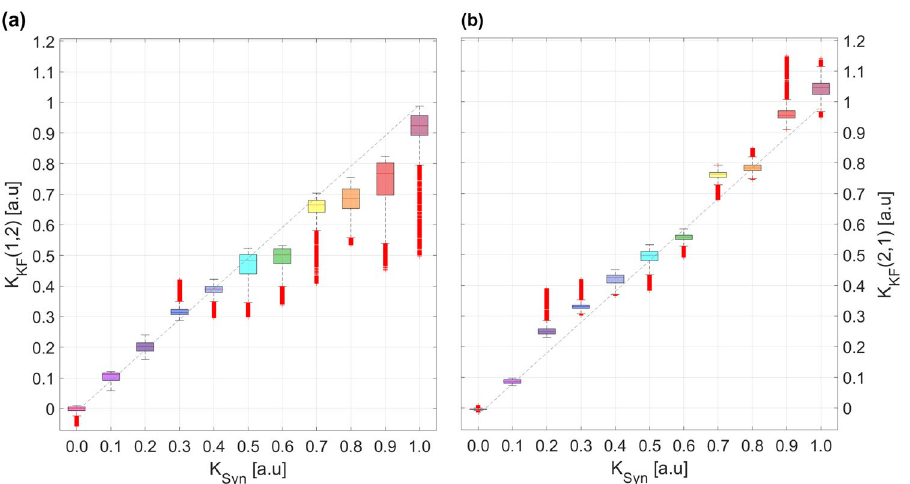
Figure 5. Comparison between the UKF estimated product of the off-diagonal adjacency matrix terms, A 12 and A 21 , times the coupling strength, K ( K 12 ≡ K · A 12 and K 21 ≡ K · A 21 ) versus the real value K . The comparison is made using boxplots. ( a ) Comparison for K 12 . ( b ) Comparison for K 21 . For each boxplot, the red line is the median, the upper and lower whiskers of the bars represent the maximum and minimum limits, and the red points refer to outliers. Each box contains 90,000 data obtained from independent runs of the UKF algorithm for each synthetic KA-parameters. The dashed-black diagonal line indicates the value where the synthetic KA and the estimated KA are the